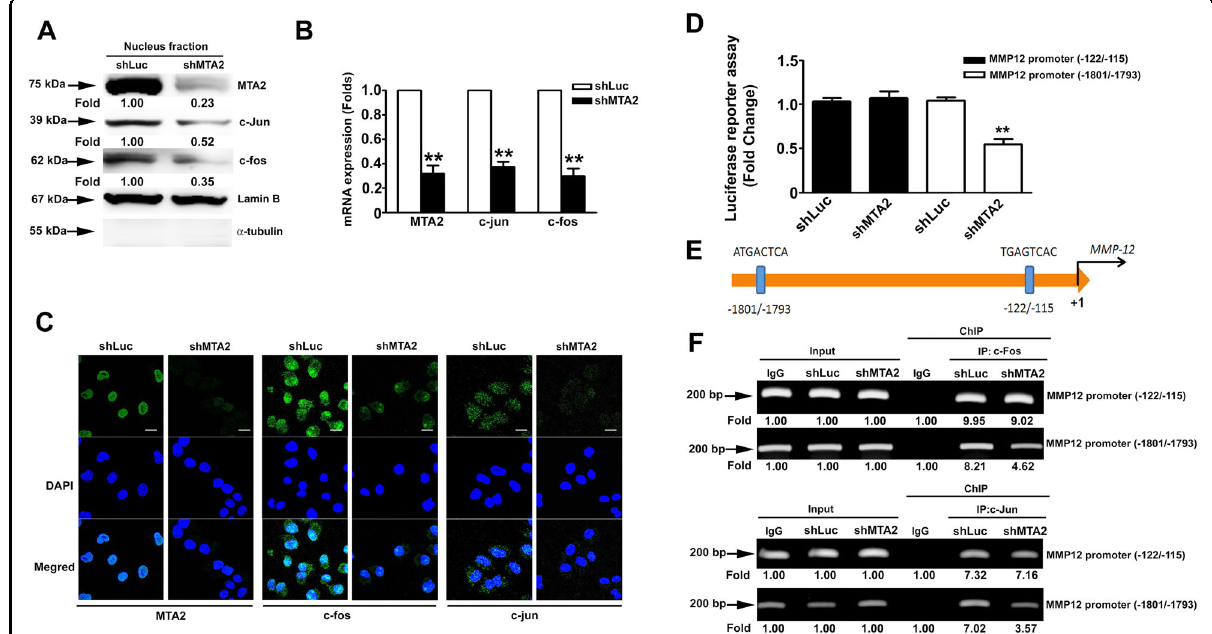
Fig. 5 Involvement of AP1(c-Fos/c-Jun) in the downregulation of MMP12 in MTA2-knockdown cervical cancer cells. Cells were infected with shRNA against MTA2 (shMTA2) and then subjected to ( A ) nucleus fractionation and immunodetection of nuclear MTA2 and AP1(c-Fos/c-Jun), ( B ) mRNA expression assessment via qRT-PCR, or ( C ) immuno fl uorescent detection of MTA2, c-Fos, and c-Jun by confocal microscopy. ( D) Cells were transfected with luciferase reporter vectors containing the MMP12 promoters ( − 122/ − 155) or ( − 1801/ − 1793), transfected with shMTA2, and then subjected to report assay. ( E) Predicted AP1 binding sites on the MMP12 promoter. ( F) Cells were transfected with shMTA2 and then subjected to ChIP by using antibodies against c-Fos or c-Jun and PCR analysis. ** P < 0.01 compared with shLuc